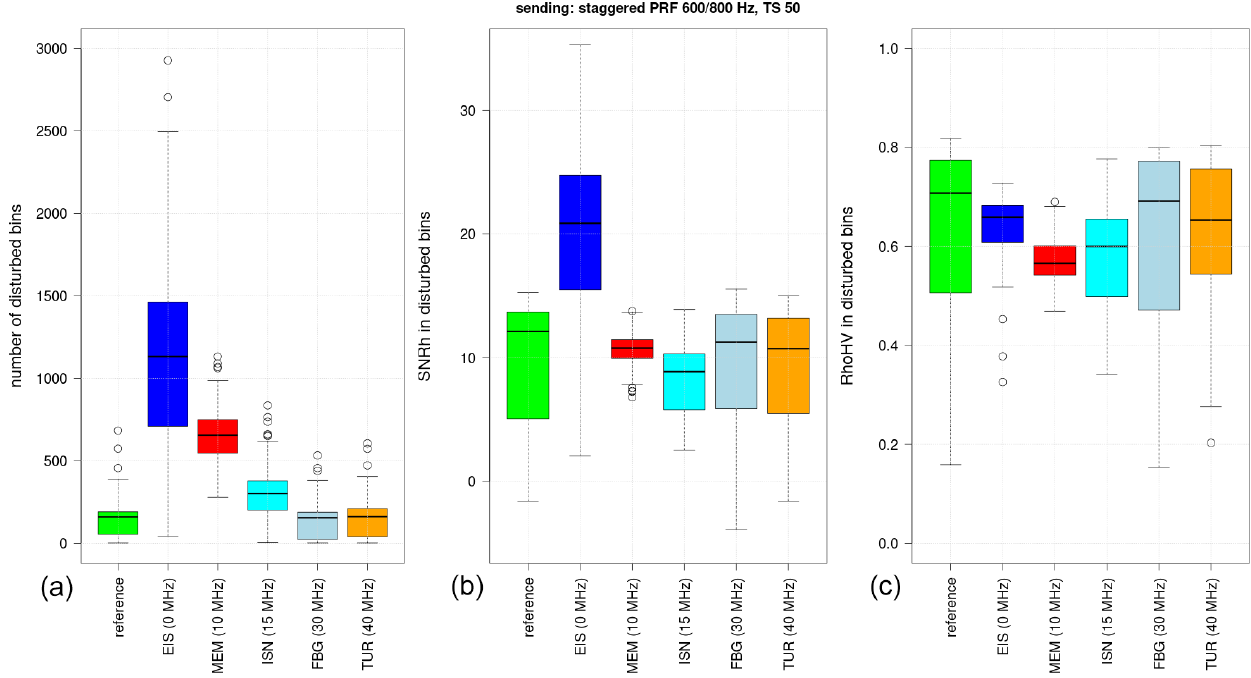
Figure 8. Boxplot of the number of disturbed bins (a) , the SNR in these pixels (b) and the RhoHV in these pixels (c) during the third period as described in Sect. 3.2. The values behind the radar names give their difference in sending frequency relative to the MHP radar.